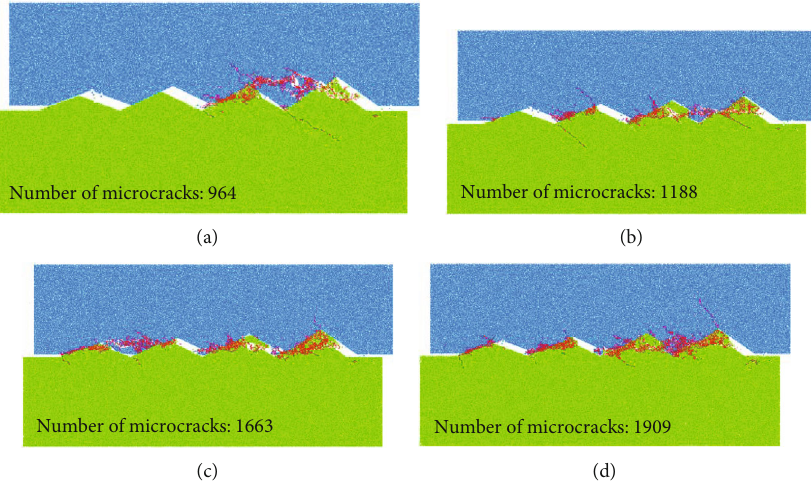
Figure 11: Failure diagram of jointed sample under di ff erent normal stresses (joint 7).